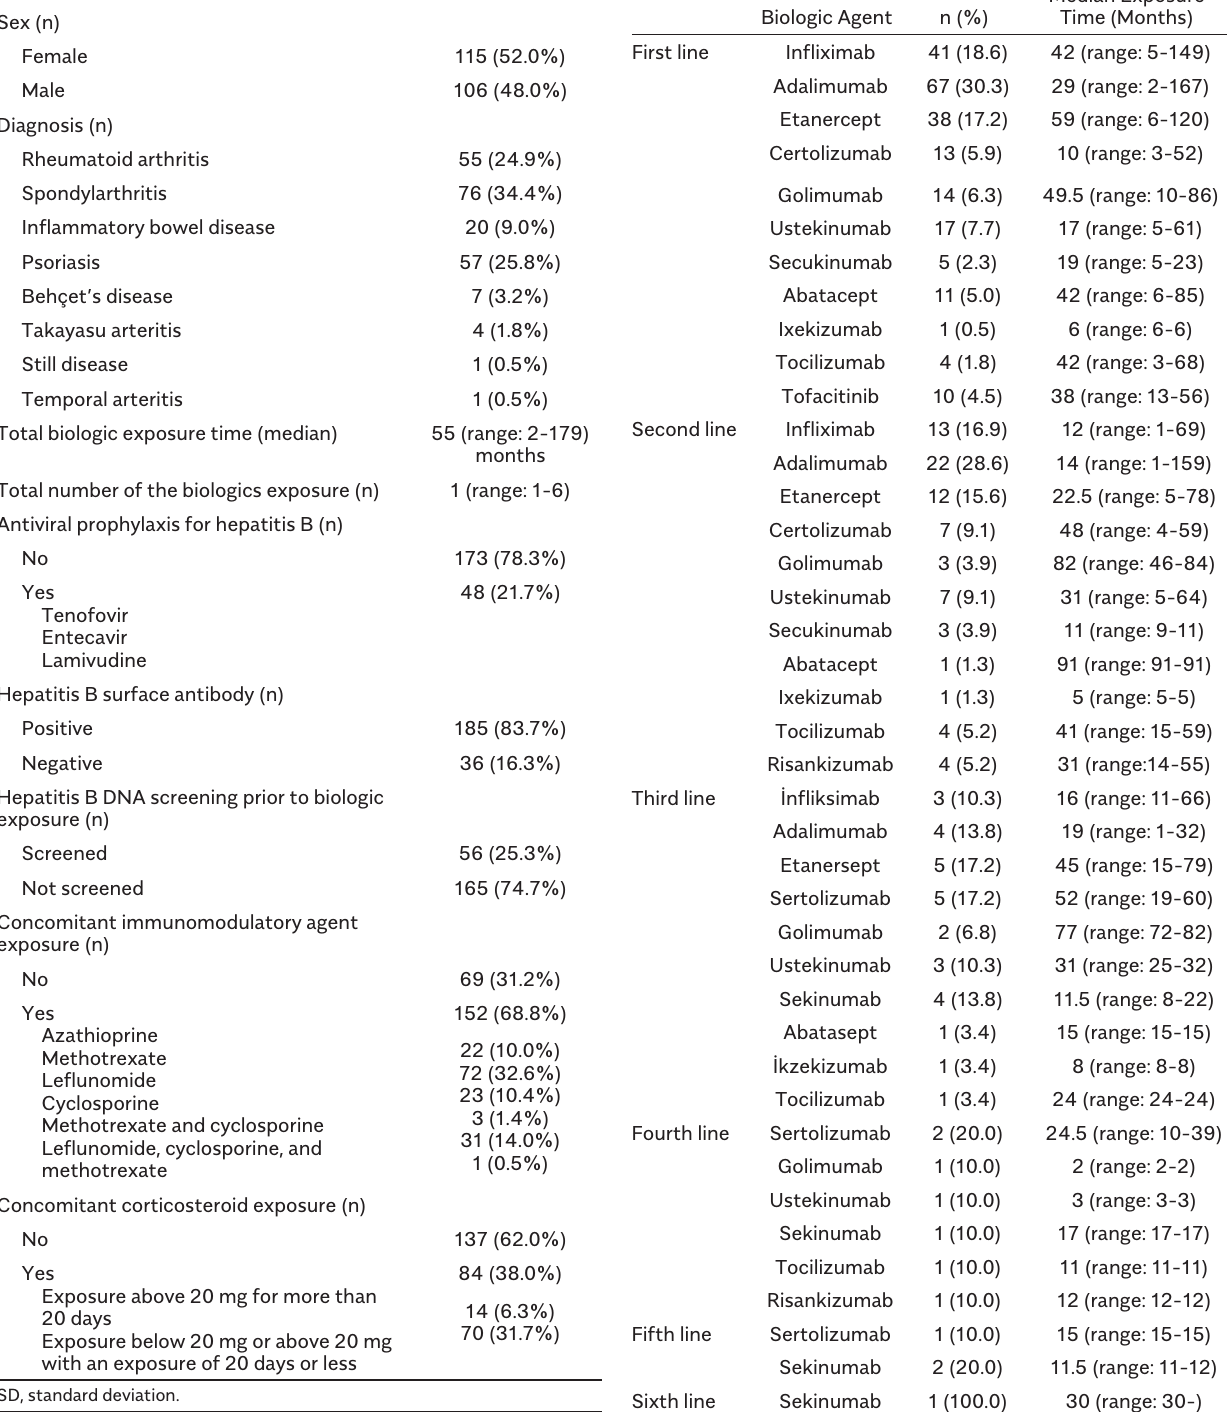
Table 1. Sociodemographic and Clinical Variables of Immune- Mediated Inflammatory Disease Patients Age (mean ± SD) 54.08 ± 11.69 years